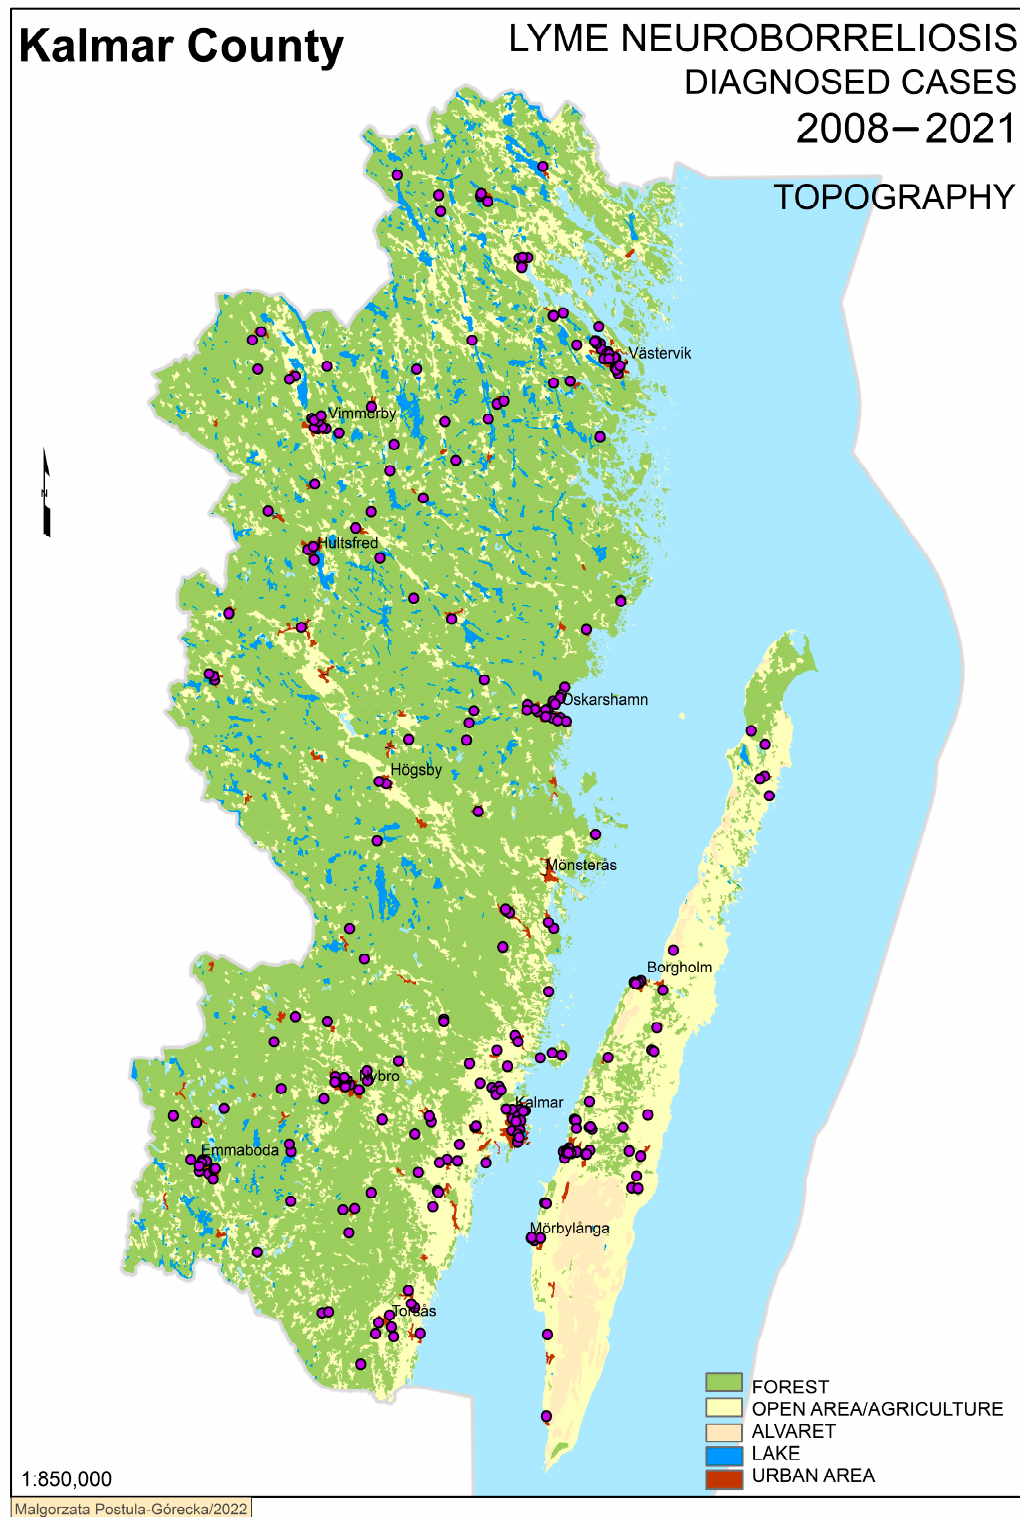
Figure 2. Lyme neuroborrelisos case distribution with topographical overlay within Kalmar County,